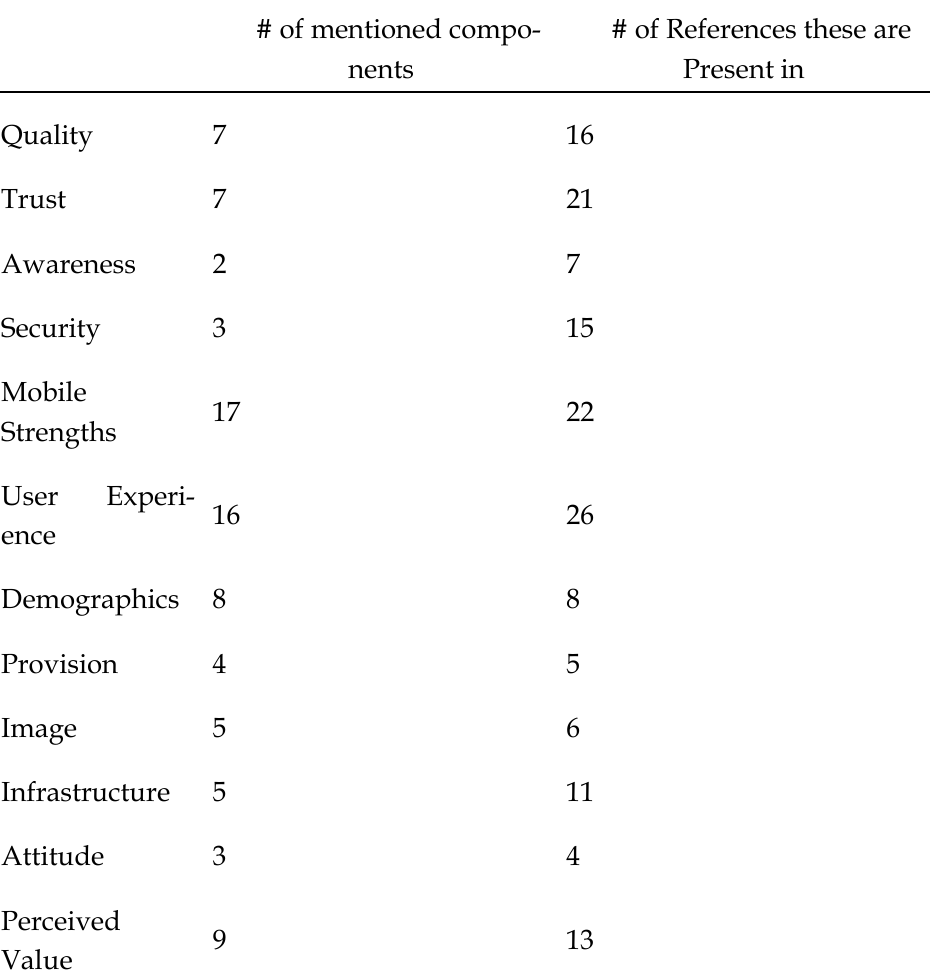
Table1: Key factors and their components